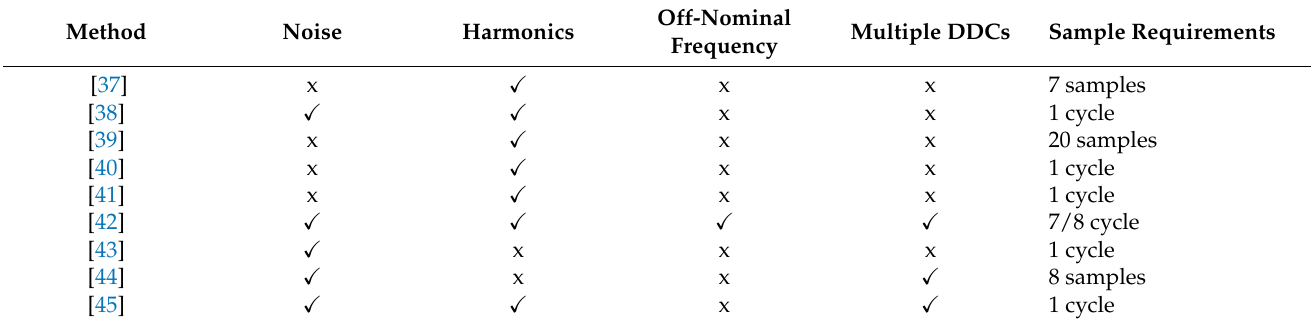
Table 4. LS-based methods—a comparative analysis in the presence of destructive